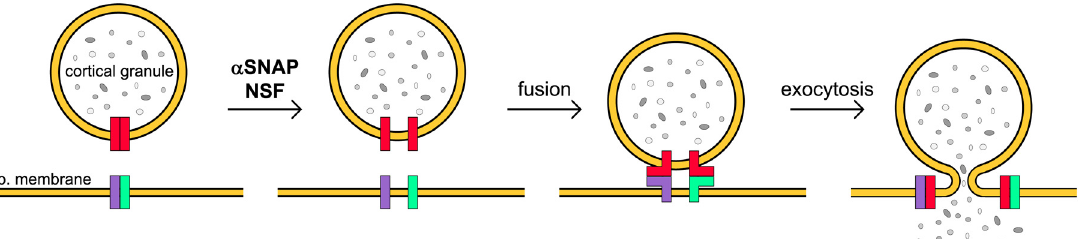
Fig 7. Working model for α -SNAP and NSF in CGE. When MII oocyte is activated by fertilization or by parthenogenesis, α -SNAP ( α SNAP) and N- ethilmaleimide sensitive factor (NSF) disassemble cis- SNARE complexes (red, in cortical granules; green and purple, in plasma membrane) making their components available to allow the formation of trans-SNARE complex (red-purple and red-green complexes) for membrane fusion and secretion. p. membrane: plasma